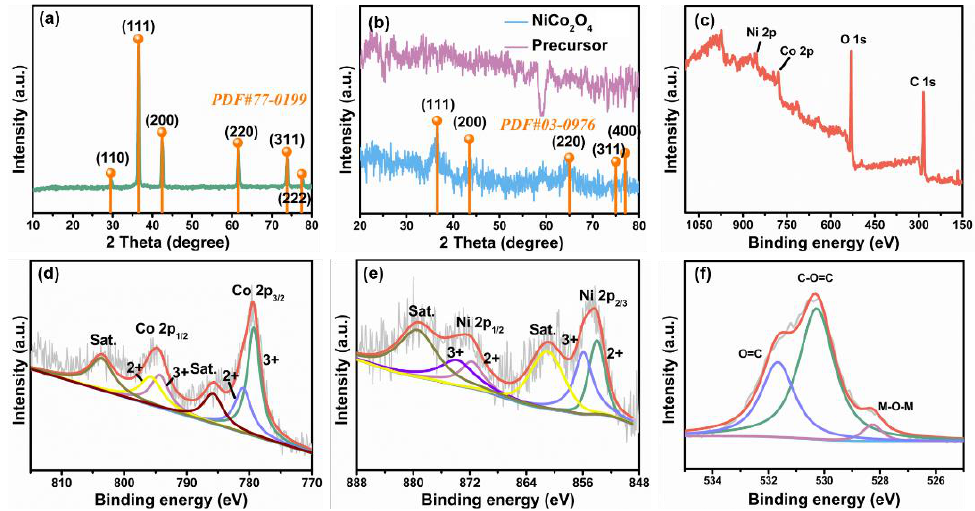
Figure 2. XRD pattern of ( a ) Cu 2 O, ( b ) Ni-Co hydroxide precursor and NiCo 2 O 4 ; ( c ) XPS survey of NiCo 2 O 4 , ( d ) Co 2p, ( e ) Ni 2p and ( f ) O 1s.